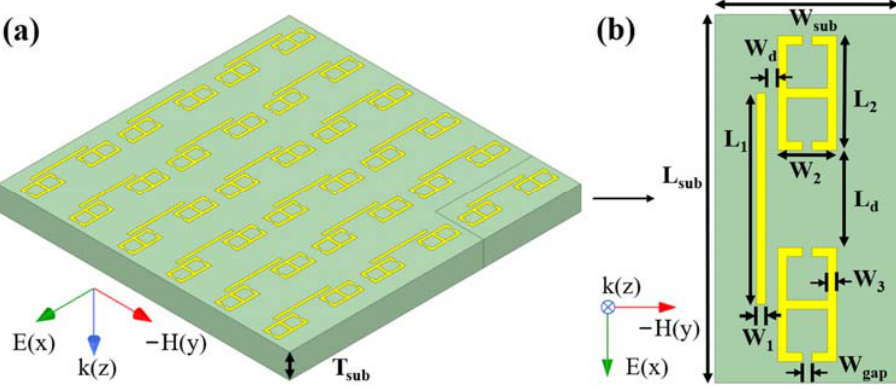
Figure 1. Schematic of the proposed EIT MTM device and the coordinate systems. ( a ) Periodic array. ( b ) Top view of one unit cell. ( T sub = 100 μ m, W sub = 200 μ m, L sub = 400 μ m, L 1 = 230 μ m, W 1 = 10 μ m, L 2 = 124 μ m, W 2 = 64 μ m, W 3 = 10 μ m, W gap = 10 μ m, L d = 106 μ m, W d = 13 μ m). The coordinate systems show the corresponding polarization direction of the incident waves.